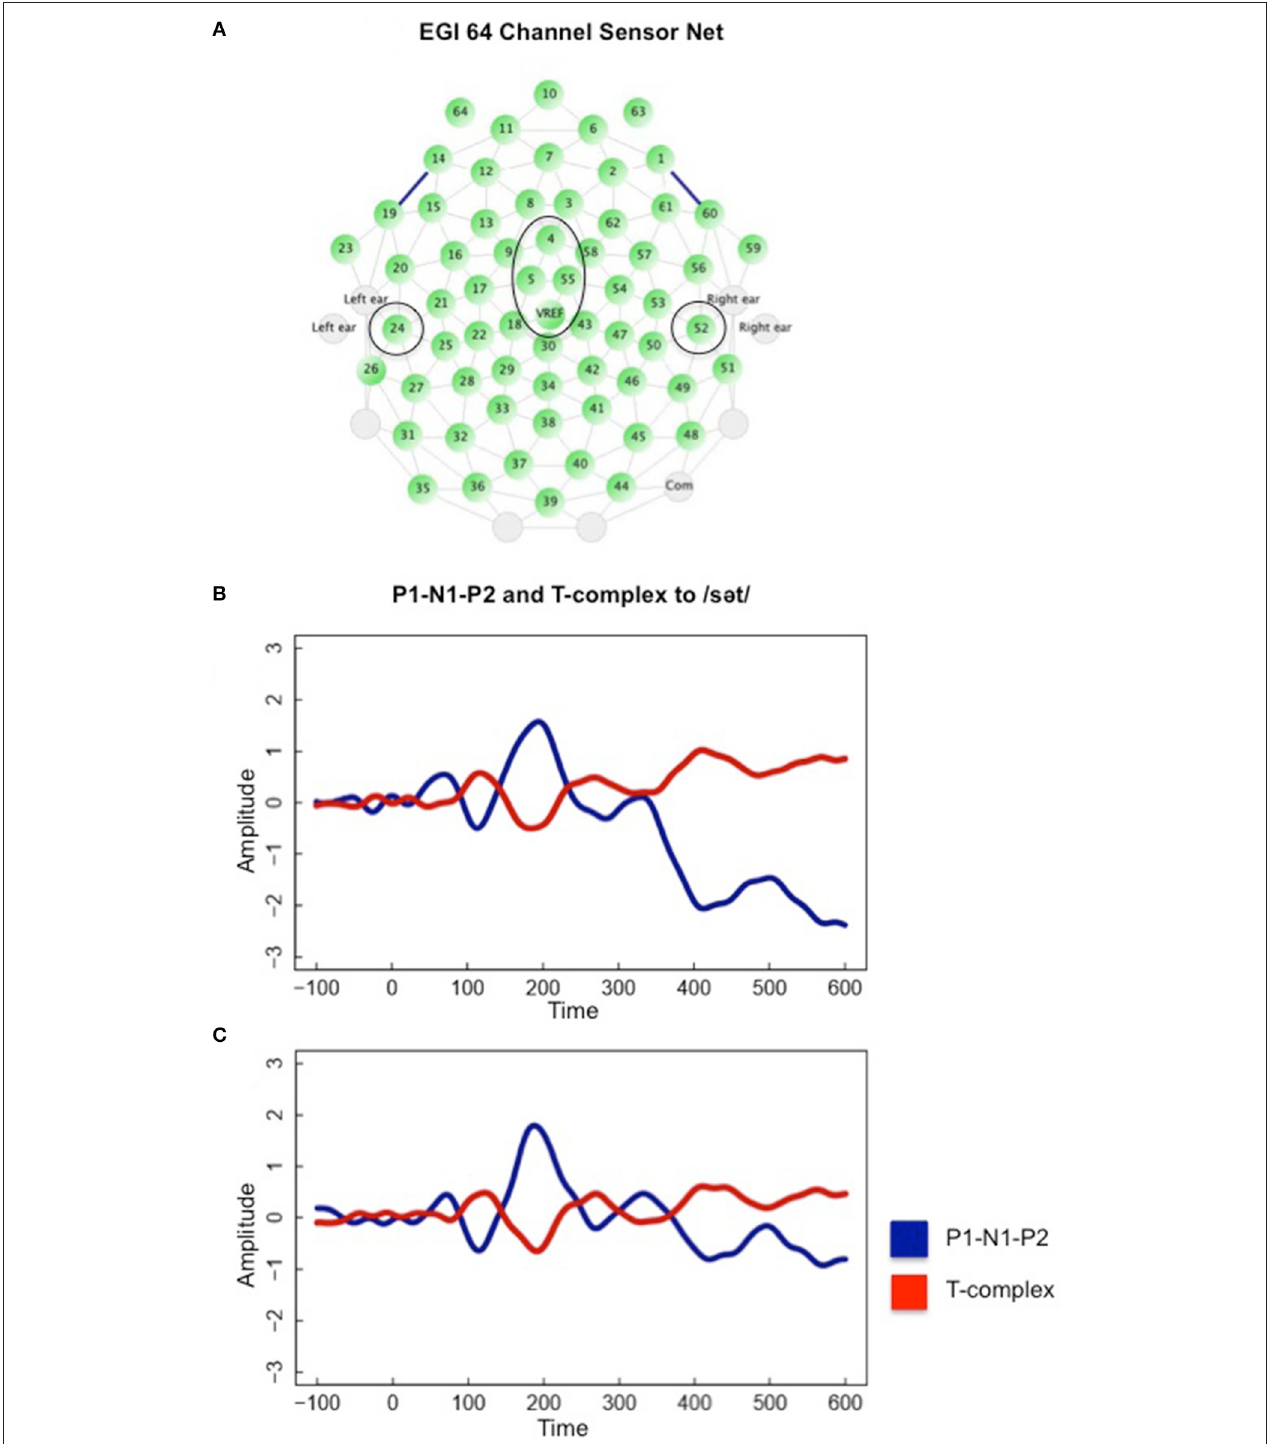
FIGURE 1 | (A) The Electrical Geodesics Inc. (EGI) sensor net and fronto-central and posterior temporal electrodes described in the text. Also shown is an overlay of P1-N1-P2 and T-complex to the /set/ onset in the English Attend 1 participant group during (B) the “with task” condition and the (C) “without task” condition. Notice that T-complex peak latencies are similar to P1-N1-P2 peak latencies in response to a specific phoneme sequence onset.